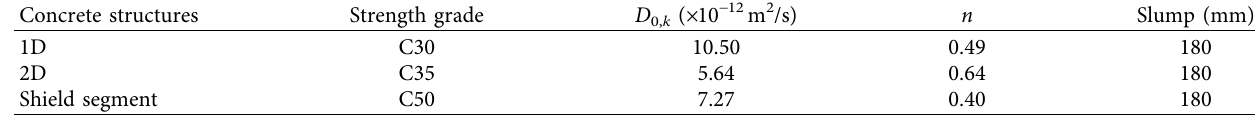
Table 5: Te indices of compressive strength, durability, and workability of concrete. Concrete structures